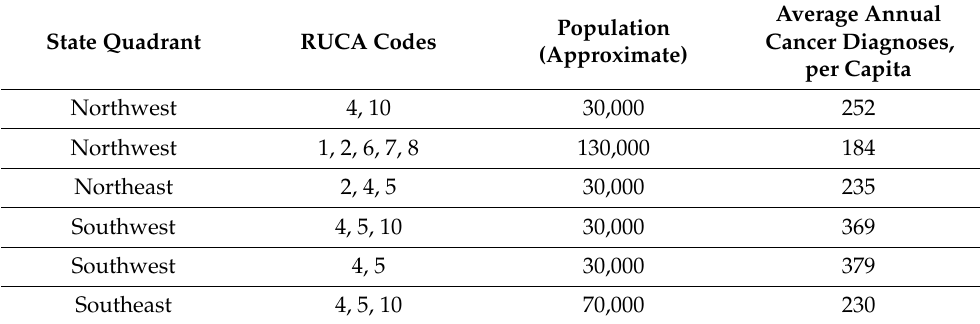
Table 1. Characteristics of Selected